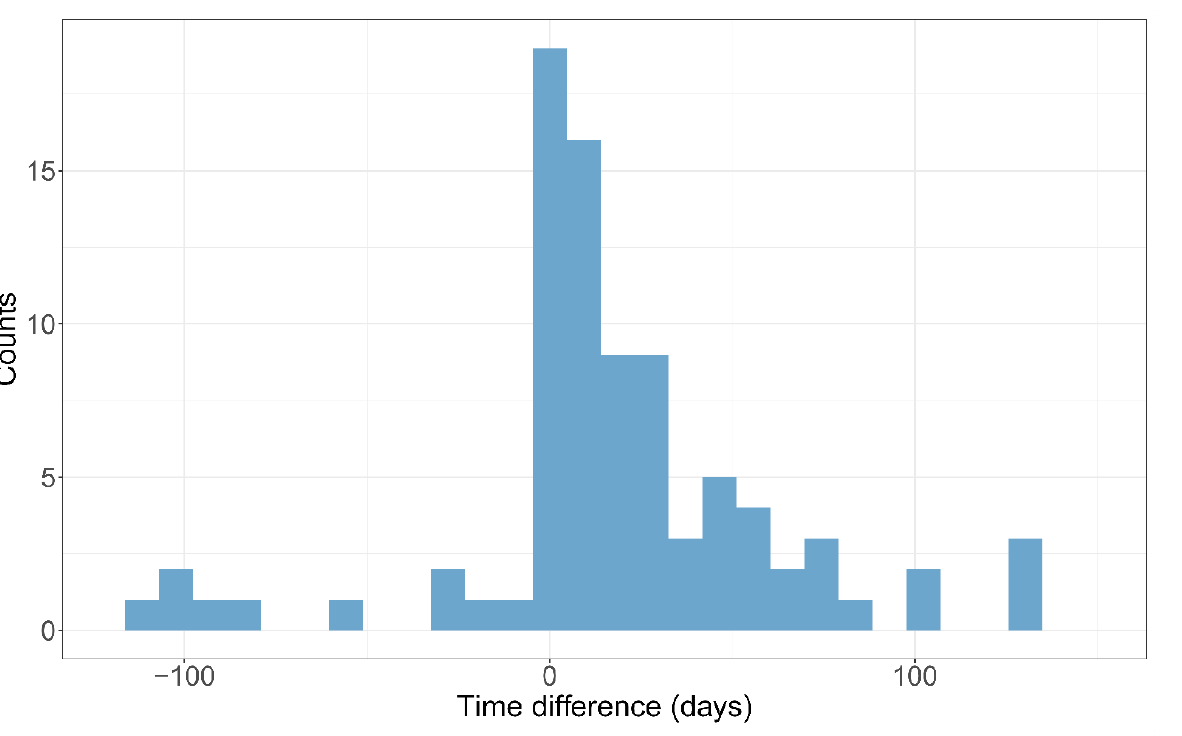
Figure 7. Accuracy of estimated fire dates amongst LTS fire polygons. The time difference is the time (in days) between the estimated fire date in LTS fire and the date of the fire event in the gov- ernmet (FSD/AFCD) fire records.